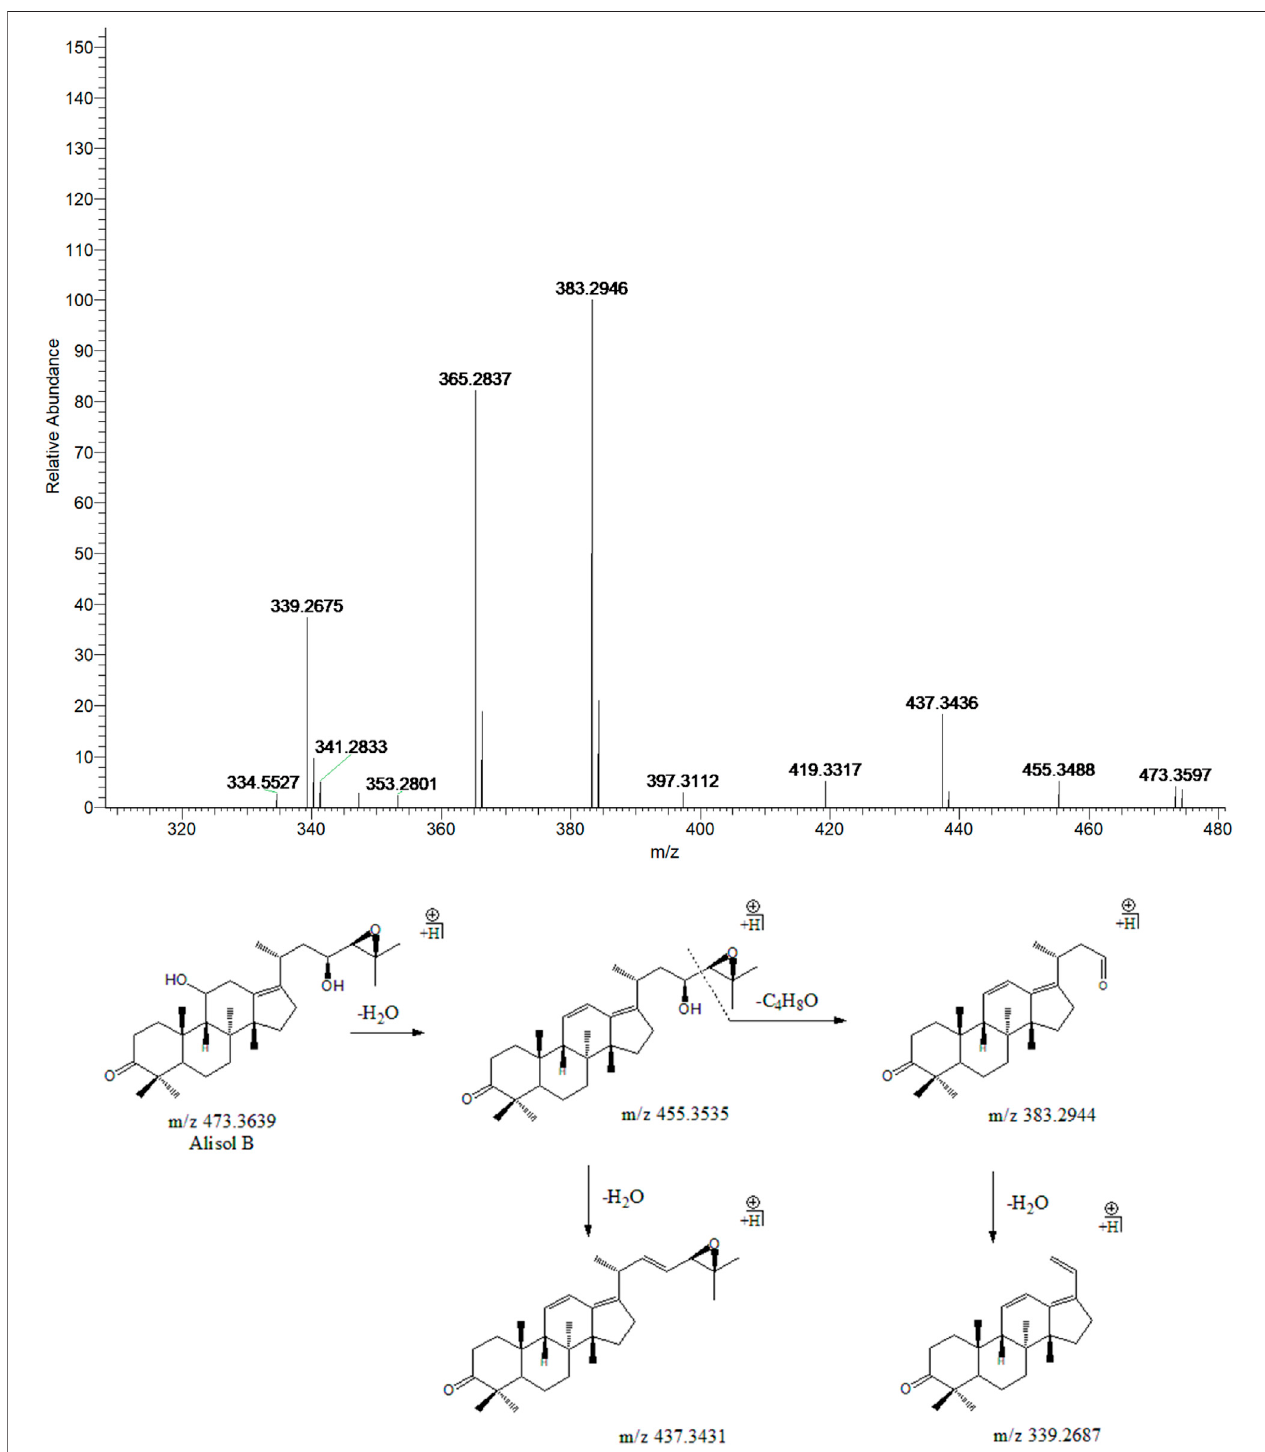
FIGURE 4 | The second-order mass spectrometry graphs and proposed fragmentation pathways of alisol B and alisol B 23-acetate (peaks 18 and 19).